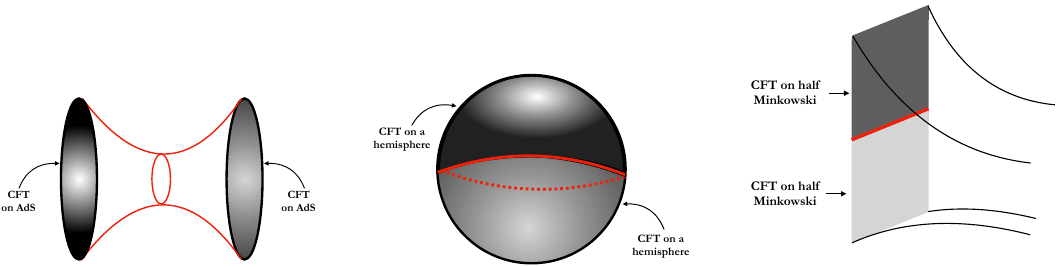
Figure 2 . Fixed-time d -dimensional sections of AdS d +1 written in different coordinates. Left: AdS-slicing wormhole. The boundary is composed of two AdS spaces and a “side” boundary (red). Center: global AdS interface. The boundary is made of two hemispheres joined at the equator, which is identified with the whole “side” boundary of the left figure. Right: Poincaré AdS interface. The boundary is made of two halves of flat space joined on a straight line. These space-times are all locally diffeomorphic, but the coordinate transformation from one to the other changes the geometry of the conformal